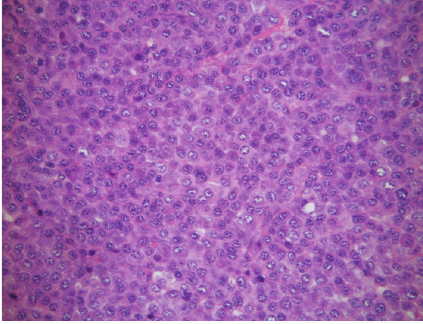
Figure 4: Neoplastic cells showed diffuse membrane positivity for CD138 at immunohistochemical